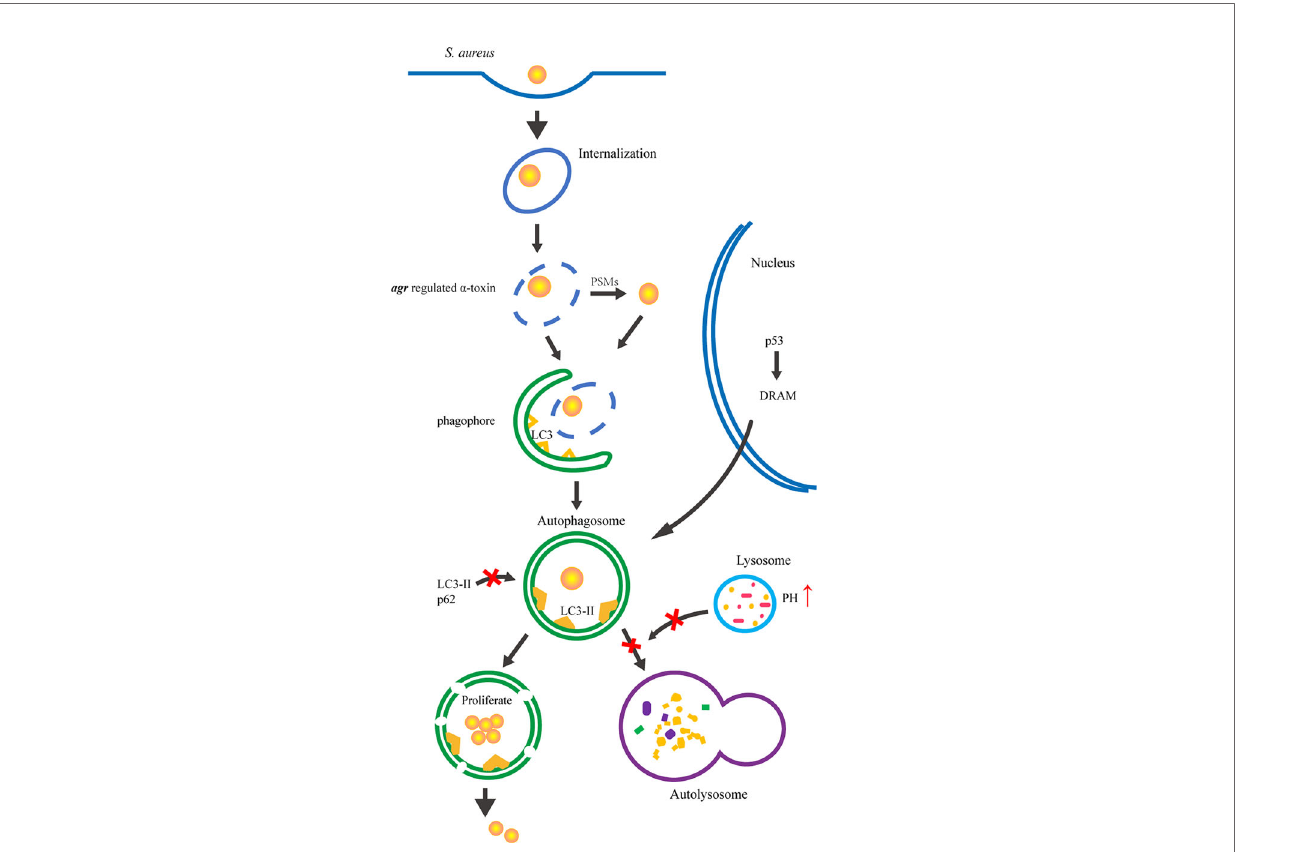
FIGURE 2 | The interaction between autophagy and agr locus of S. aureus . S. aureus is internalized into host cell via the endocytic pathway. Agr system positively regulates a -toxin and PSMs to mediate escape from the phagosome into cytoplasm. The escaped S. aureus and damaged phagosomes are engulfed by phagophores. The expression of LC3-II and p62 are blocked by agr system to hinder autophagosomal maturation. Upon autophagosomal maturation, agr as the pH sensitive system inhibit the fusion of autophagosome and lysosome to escape autophagic degradation. Thus, the autophagosomes provide a niche for S. aureus replication. In addition, agr -speci fi c factor was found to accumulate autophagosomes as intracellular survival niches by manipulating the p53/DRAM pathway in human PMNs, whereas has not been found in other species or cell types. Eventually, S. aureus escape from autophagosomes into the cytoplasm and induces host cell